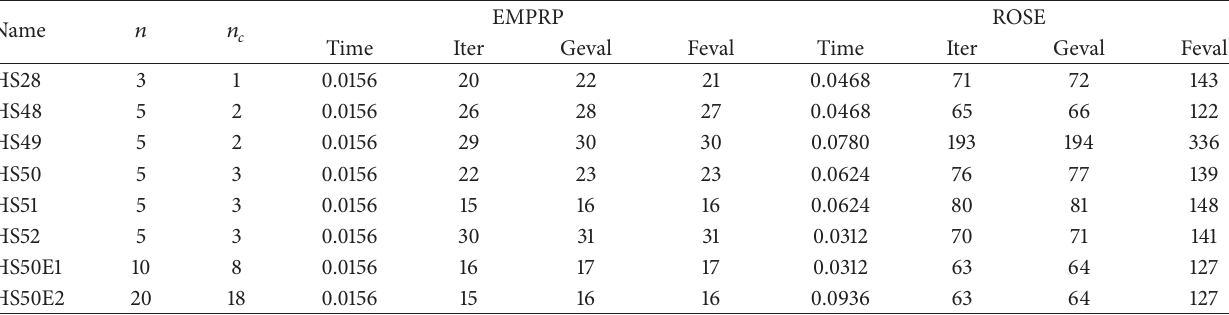
Table 1: Test results for Problems 1–5 with given initial points.